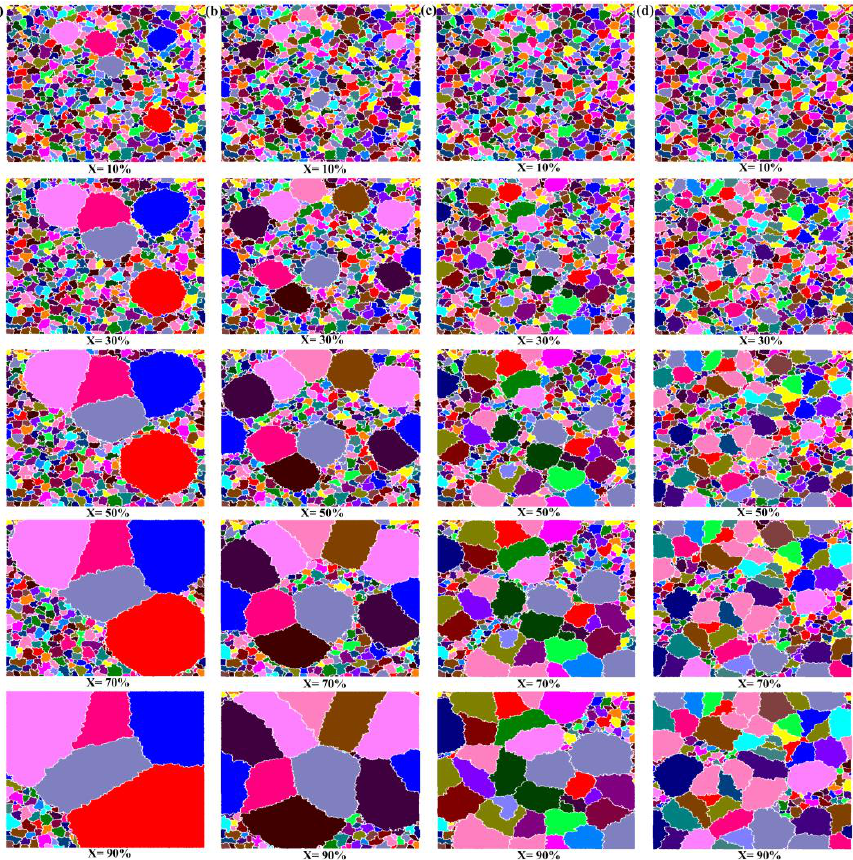
Figure 7. AGG at different area fractions with different numbers of Type II grains: ( a ) 5, ( b ) 10, ( c ) 29, and ( d ) 47.